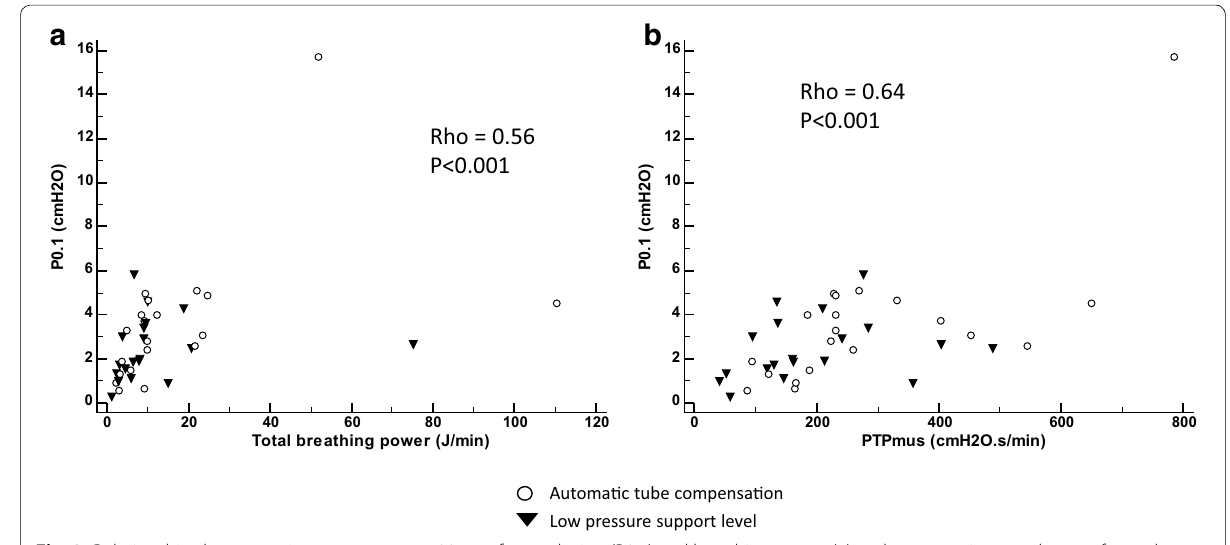
Fig. 3 Relationships between airway pressure at 100 ms after occlusion (P0.1) and breathing power ( a ) and pressure time product performed by the respiratory muscles (PTPmus) ( b ). Rho Spearman correlations are shown for all over the data points. Open circles for automatic tube compensation group and black triangles for low-pressure support group